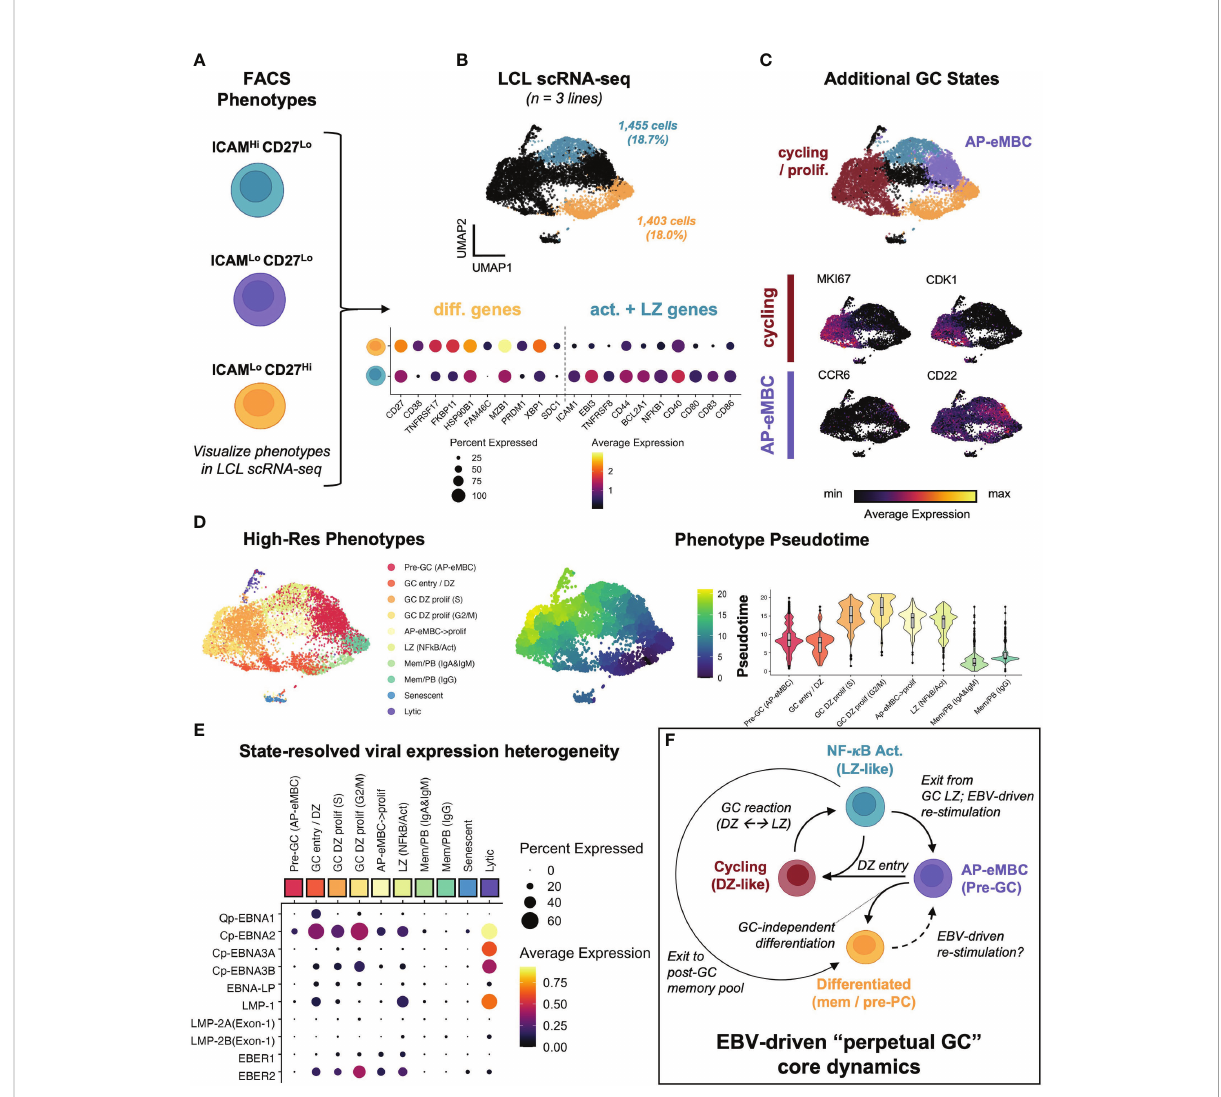
FIGURE 3 EBV perpetuates a cycle of B cell GC-like entry, engagement, and exit in vitro . (A) Dynamic phenotypes if interest from FACS experiments. (B) Mapping of ICAM-1 Hi /CD27 Lo and ICAM-1 Lo /CD27 Hi phenotypes within integrated LCL scRNA data (n = 3 LCLs). (C) Identi fi cation of additional cell states within LCLs. Representative marker gene UMAPs highlight states corresponding to actively cycling cells (red cluster) and pre-GC activated precursor/early MBCs (purple cluster). (D) Annotated clustering and pseudotime trajectory analysis of dynamic LCL states. Pseudotime scores were calculated from graphs initialized in resting MBCs (ICAM-1 Lo /CD27 Hi ) and are presented as UMAP representations and cluster- resolved pseudotime score distributions. Cluster ordered pseudotime identi fi es cyclical state progression in LCLs. (E) Pseudotime-ordered, phenotype-resolved expression of detected EBV latency genes and EBER transcripts in LCLs. (F) Integration of time-resolved FACS fi ndings, scRNA-seq, and pseudotime dynamics support a model of conserved perpetual germinal center (GC) dynamics across EBV-immortalized cells in vitro